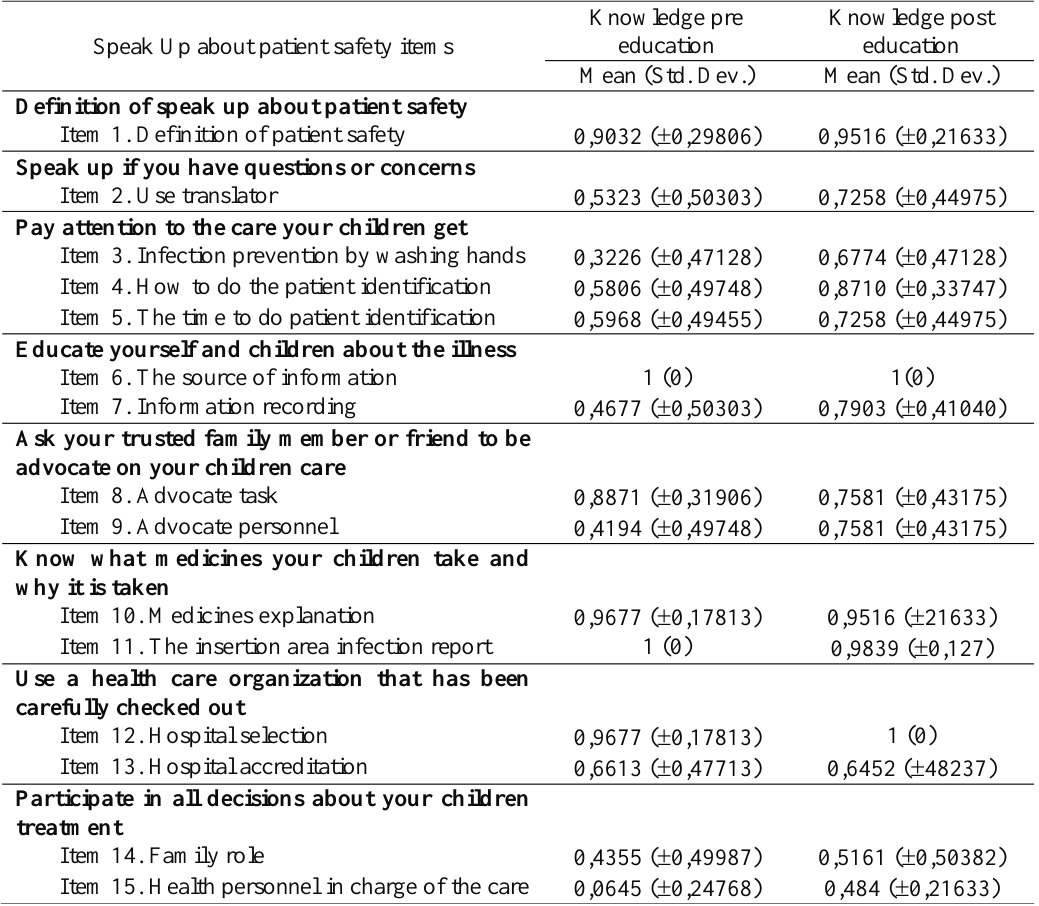
Table 1. Means of parent‟s speak up knowledge about patient safety in Children‟s Wards of Dr. Sardjito Hospital Yogyakarta